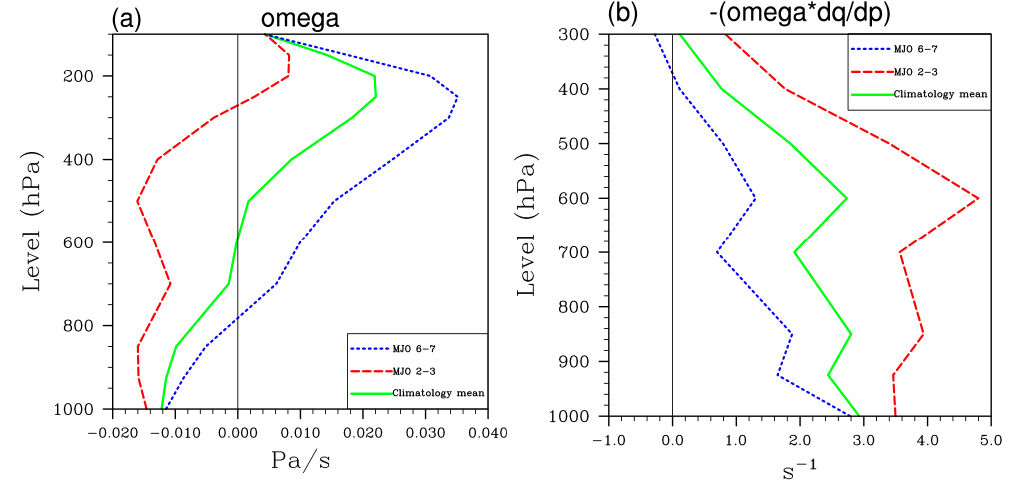
Figure 6. ( a ) Composites profiles of vertical pressure velocity (units: Pa/s) and ( b ) vertical moisture advection (units: 10 − 9 /s). Climatological values are shown in green, MJO phases 2–3 in red and phases 6–7 in blue.